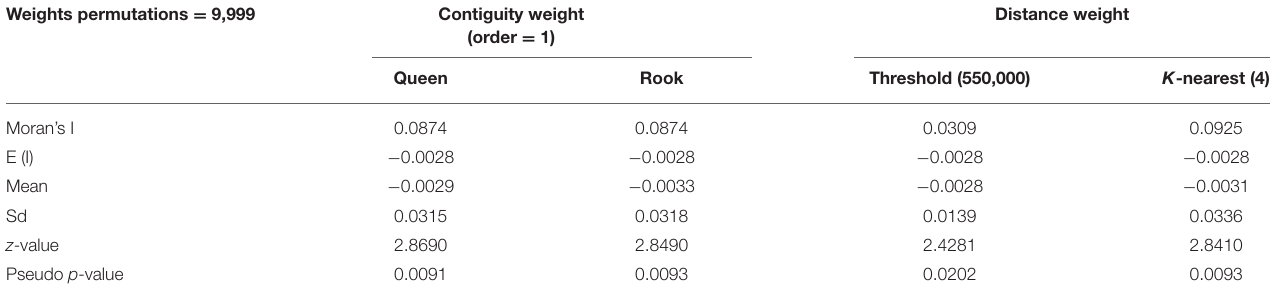
TABLE 1 | Moran’s I statistical results of the allocation of elite hospitals in China. Weights permutations = 9,999